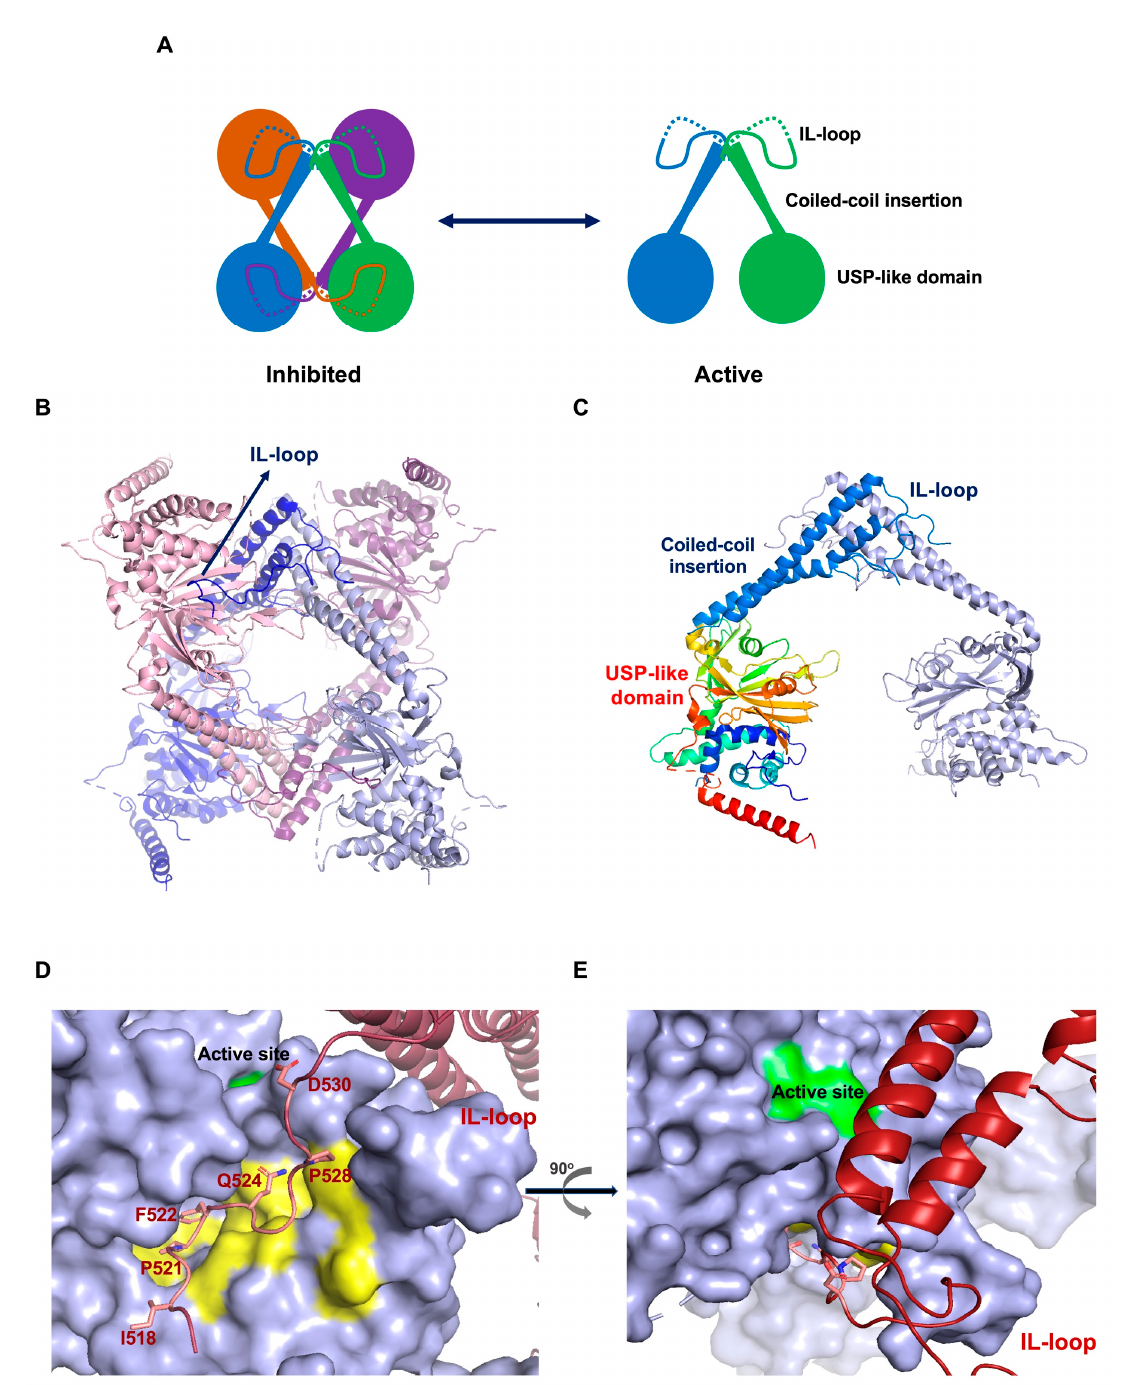
Figure 3. The structure of USP25. ( A ) Schematic cartoon representation of the USP25 tetramer and dimer assemblies. Each monomer is colored. ( B ) Crystal structure of the USP25 tetramer (PDB: 5O71 and 6HEL). Each dimer is colored blue or light pink. ( C ) Crystal structure of the USP25 dimer. IL-loop, coiled-coil insertion and ubiquitin-specific protease (USP)-like domain are marked. ( D ) Binding interface of the IL-loop with the ubiquitin-binding site of USP25. IL-loop (red), active site (green), binding surface (yellow), the interface contacts of IL-loop are labelled. ( E ) View of D rotated 90°.